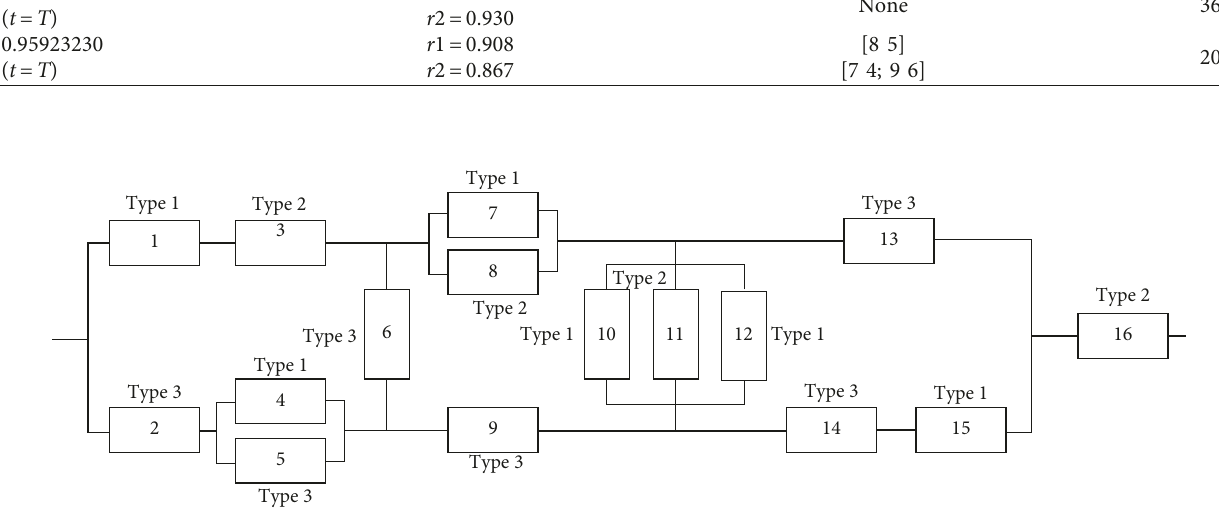
Figure 12: System with 16 components of 3 types.